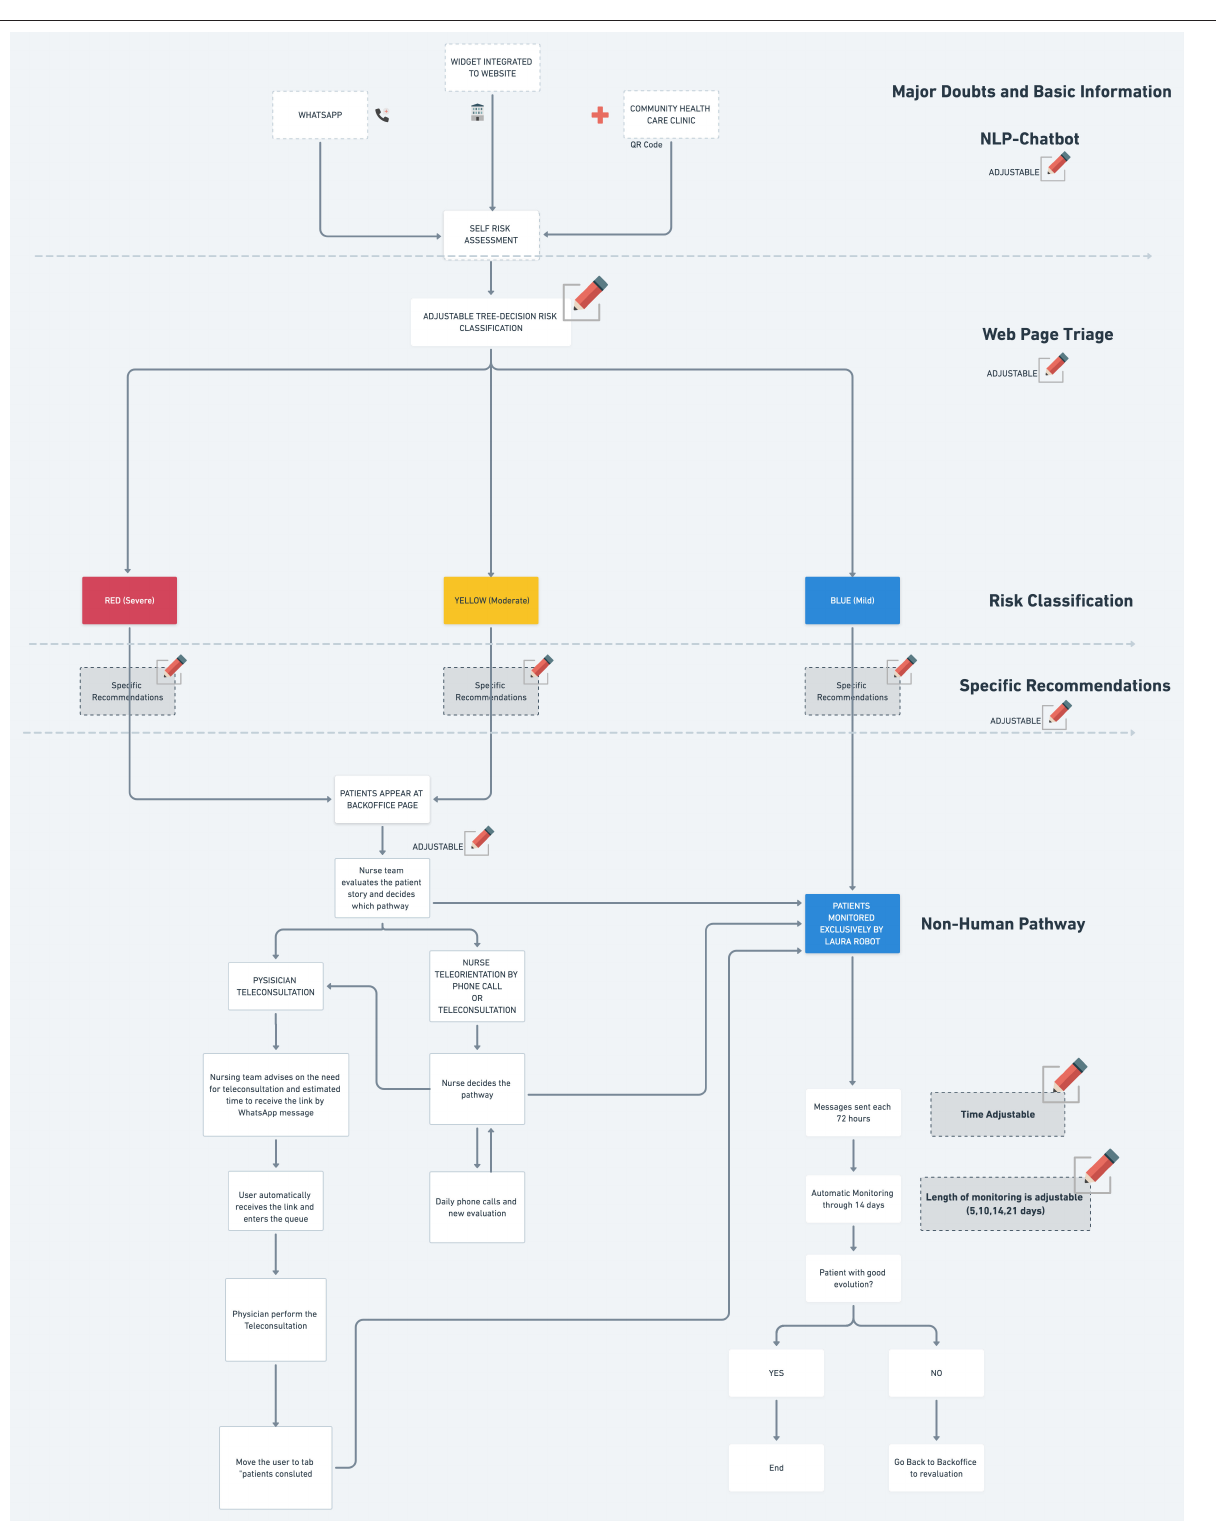
Frontiers in Digital Health |